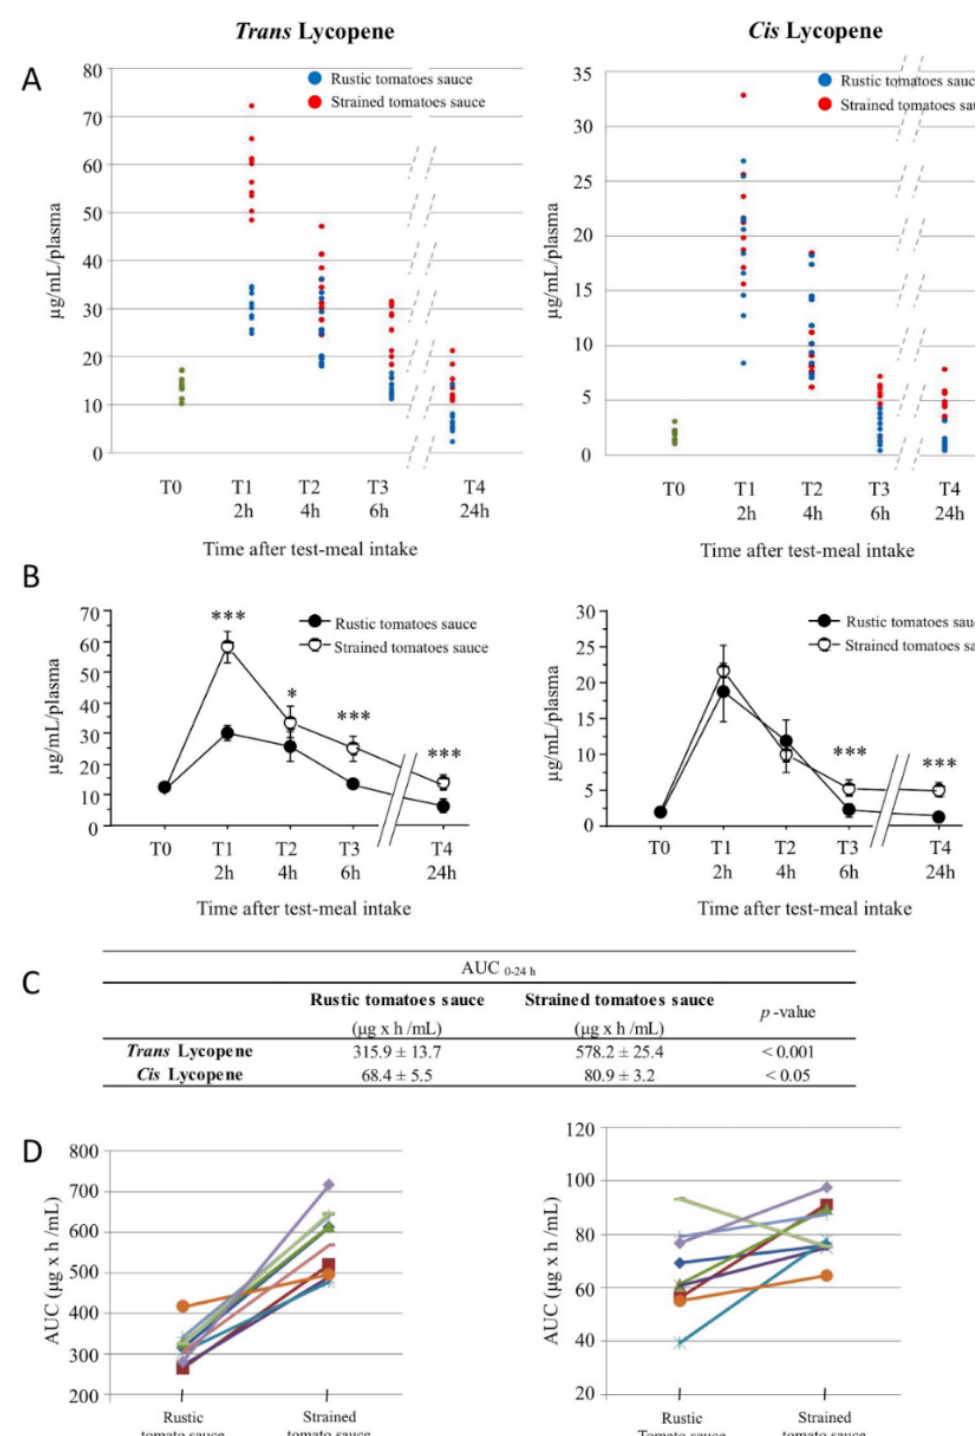
Figure 2. HPLC analysis of trans- and 5- cis -lycopene isoforms levels in plasma of the subjects after consumption of the day 1 test meal (acute-phase). ( A ) Dot plots indicate how the values relative to the single subjects are distributed according to the observation times. ( B ) The bars represent the 95% confidence intervals for the calculated averages * p < 0.05; ** p < 0.01; *** p < 0.001. ( C , D ) The area under the curve over 24 h was derived using trapezoidal approximation. ( C ) The AUC values of rustic tomato sauce and strained tomato sauce were compared using a paired Student’s t-test and expressed as mean ± SD. ( D ) Line charts indicate how the values relative to the single subjects are modified depending on the type of sauce consumed.